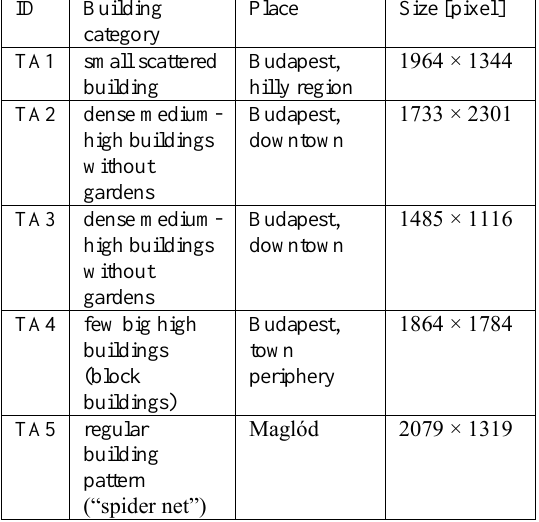
Table 1. Description of the satellite samples